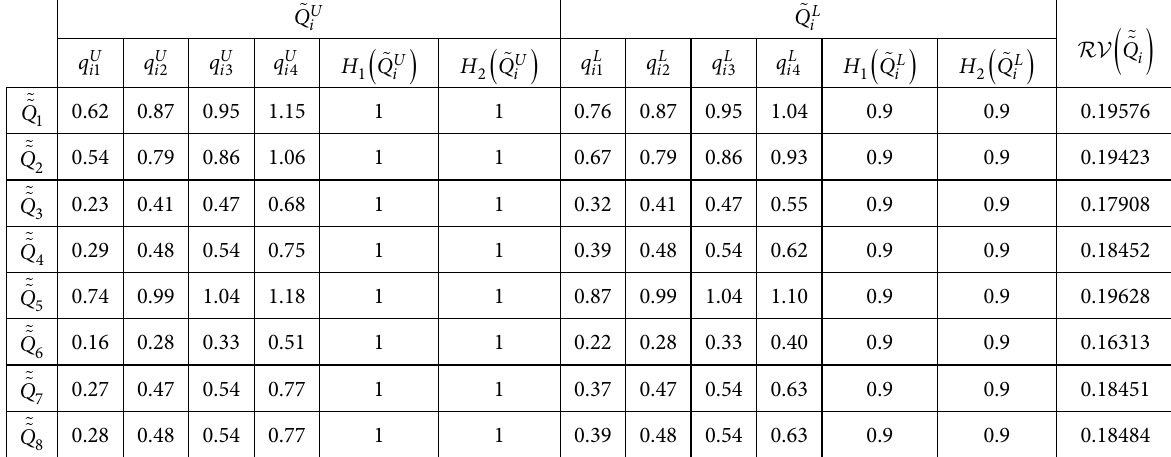
 and the corresponding ranking